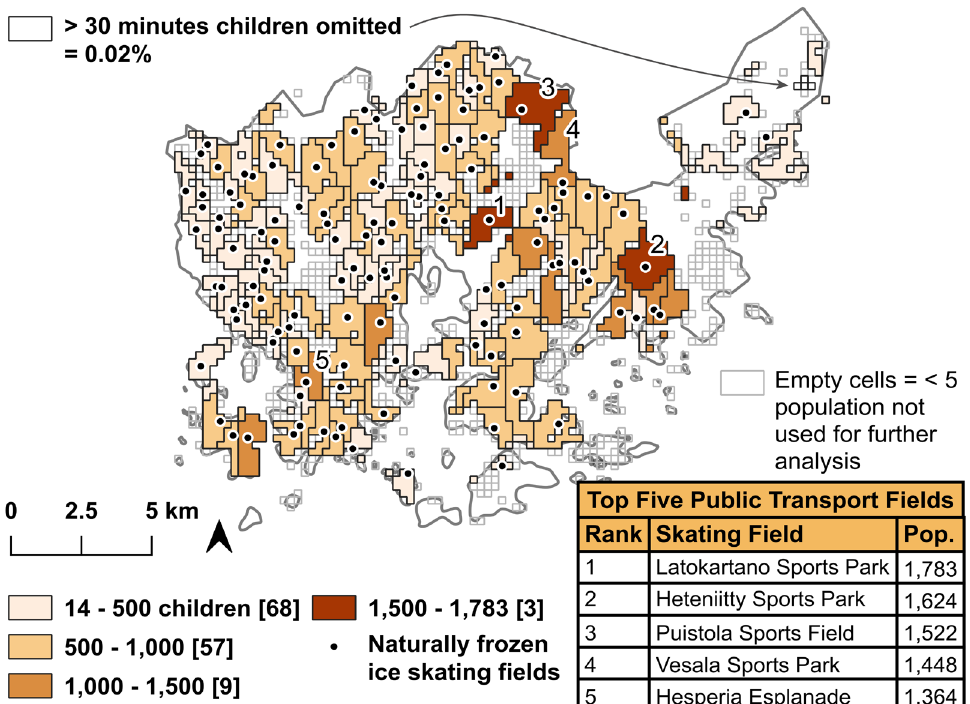
Fig. 3. Population catchment areas for children and adolescents of naturally frozen ice skating fields based on travel time by public